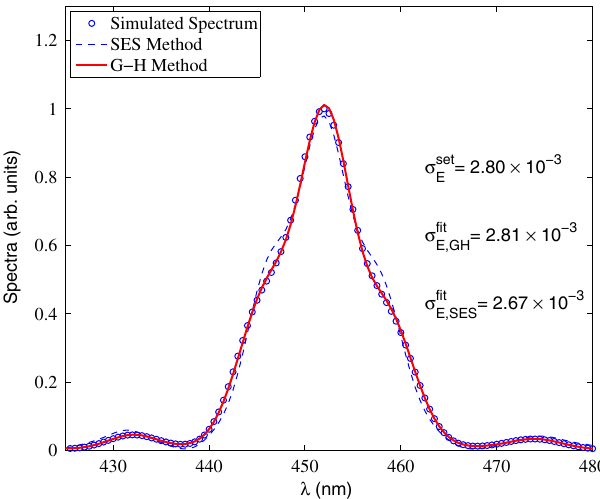
FIG. 2. (Color) A simulated spectrum and related fitted curves. The simulated spectrum is generated with (cid:1) set E ¼ 2 : 80 (cid:2) 10 (cid:1) 3 , ¼ 1 nm , and N ¼ 31 . The red solid curve is a fitted spec- (cid:3) x d trum using the G-H method; the black dashed curve is the fitted spectrum using the SES method. The fitted values of the energy spread using both methods are listed in the